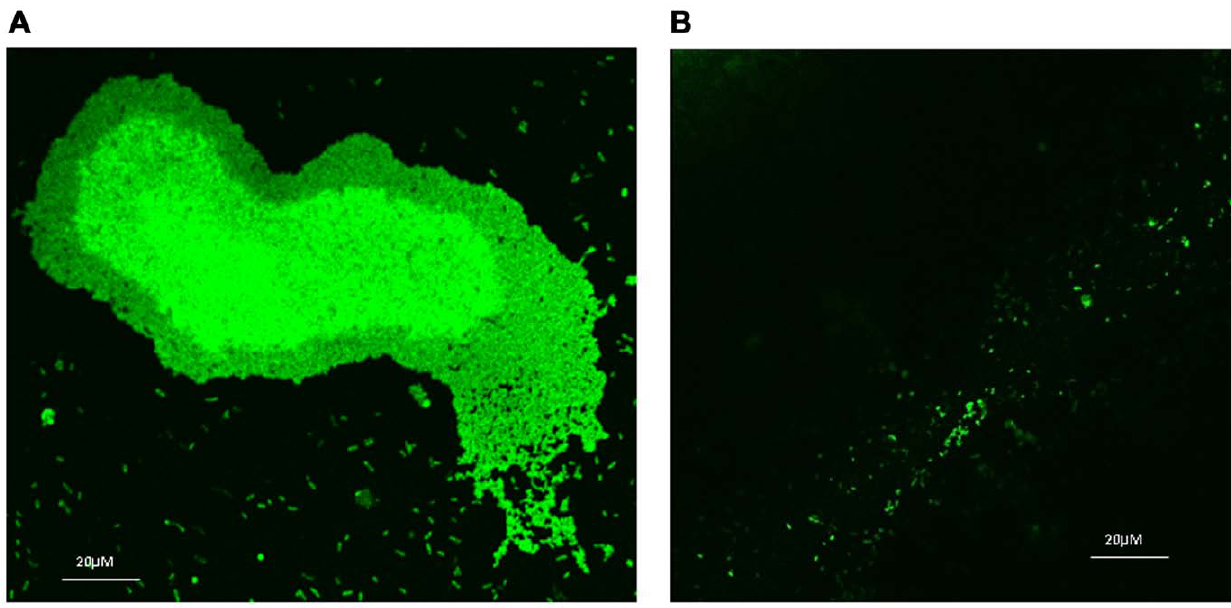
Figure 4. CLSM images of biofilm formed by P.aeruginosa PAO1 (63X magnification) A)Untreated B) Treated with 1 mg/ml F7.